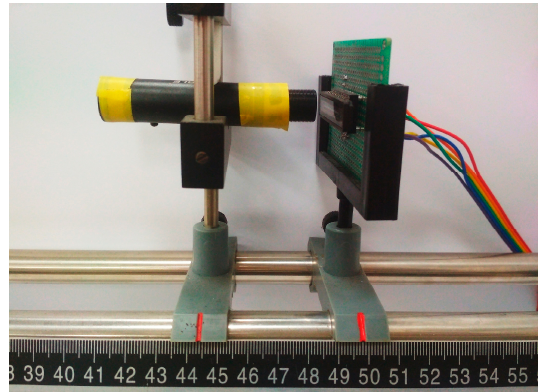
Figure 12. Laboratory portable smart spectrometer.